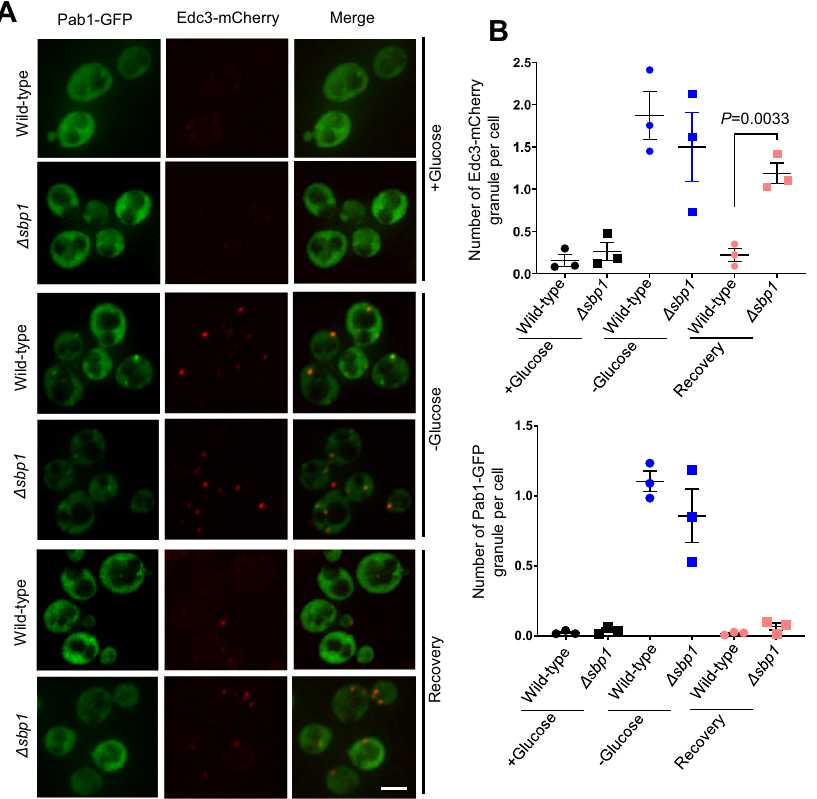
Fig. 3 Edc3-mCherry granule disassembly defect is not stress-speci fi c. A Live-cell microscopy to observe disassembly of PBs and SGs formed upon stress condition in wild-type and Δ sbp1 strain. Scale Bar, 3 µ m. B Graph depicting the number of PBs (top panel) and SGs (bottom panel) per cell in wild-type and Δ sbp1 strains in various culture conditions during granule recovery experiment. Data plots represent mean ± SEM from of n = 3, where ‘ n ’ represents number of independent experiments. A two-tailed paired student t -test was used to calculate P